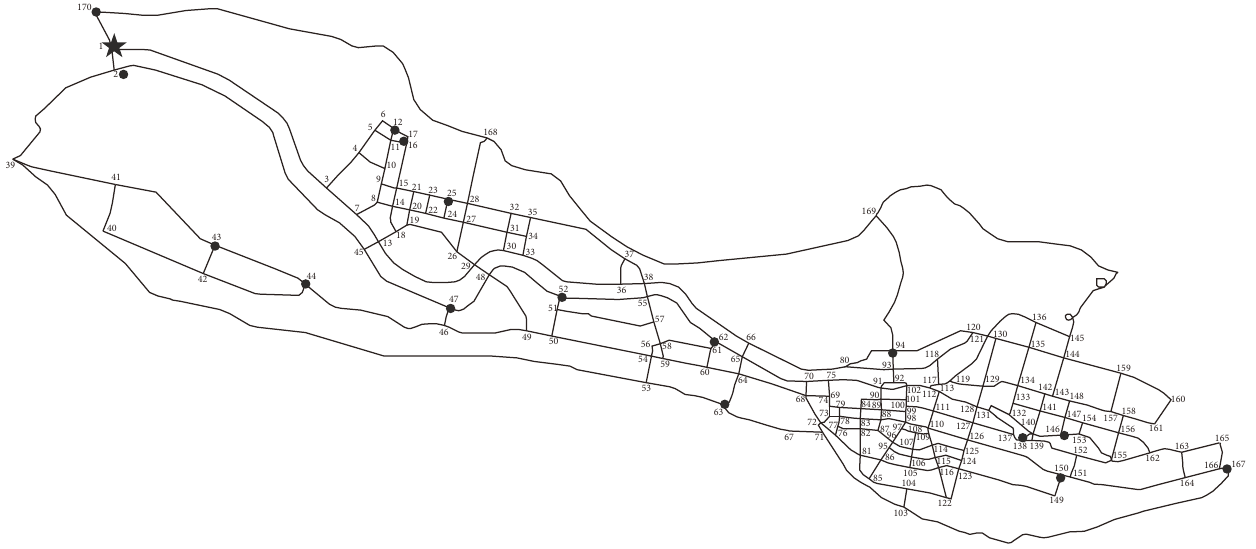
Figure 7: A transport network for hazardous materials in main districts of Lanzhou.